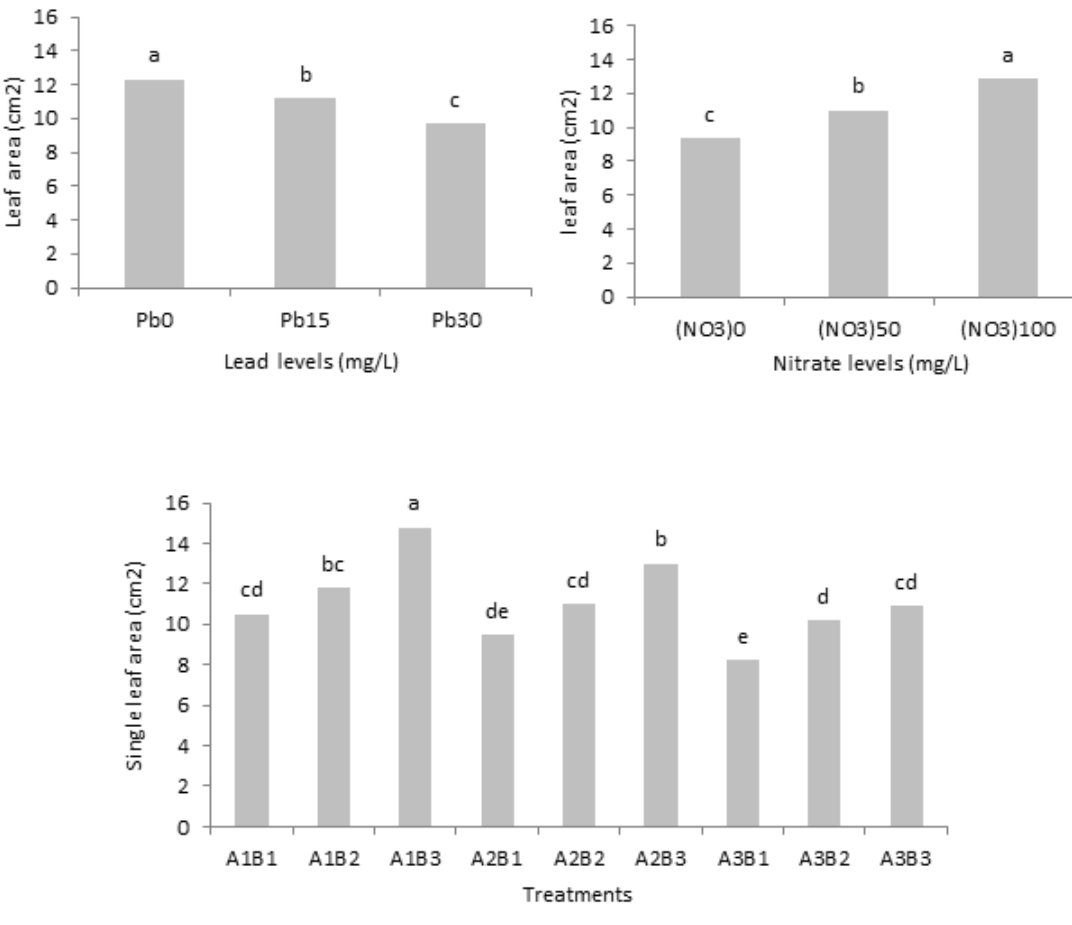
Figure 2: The leaf area of Judas tree plants under lead and nitrate interaction treatments. Treatments indicate lead levels (A: 0, 15, 30 mgL -1 ) and nitrate levels (B: 0, 50, 100 mgL -1 ). Data are average of four replications ±SD. Comparison of means was done at 5% level of LSD